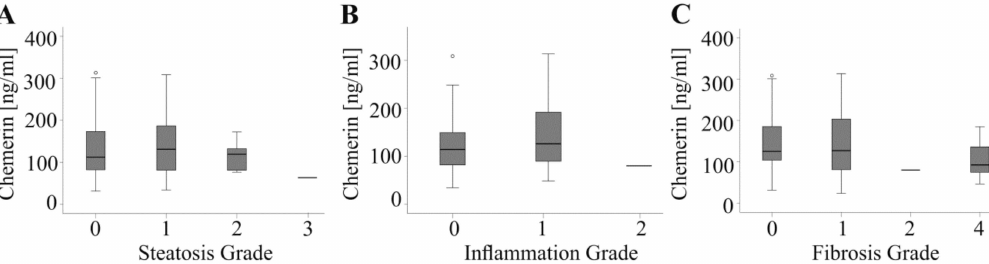
Figure 5. Serum chemerin and liver injury in cancer patients. ( A ) Chemerin in patients stratified for hepatic steatosis (25 patients: no steatosis; 27 patients grade 1; 5 patients grade 2 and 1 patients grade 3; Steatosis grade of 10 patients was not known) ( B ) Chemerin in patients stratified for hepatic inflammation (28 patients: no inflammation; 29 patients grade 1 and 1 patient grade 2. Inflammation grade of 9 patients was not known). ( C ) Chemerin in patients stratified for hepatic fibrosis (28 patients: no fibrosis; 25 patients grade 1; 1 patient grade 2 and 14 patients grade 4). Number of patients in some subgroups was 1 and statistical test is not reliable for these